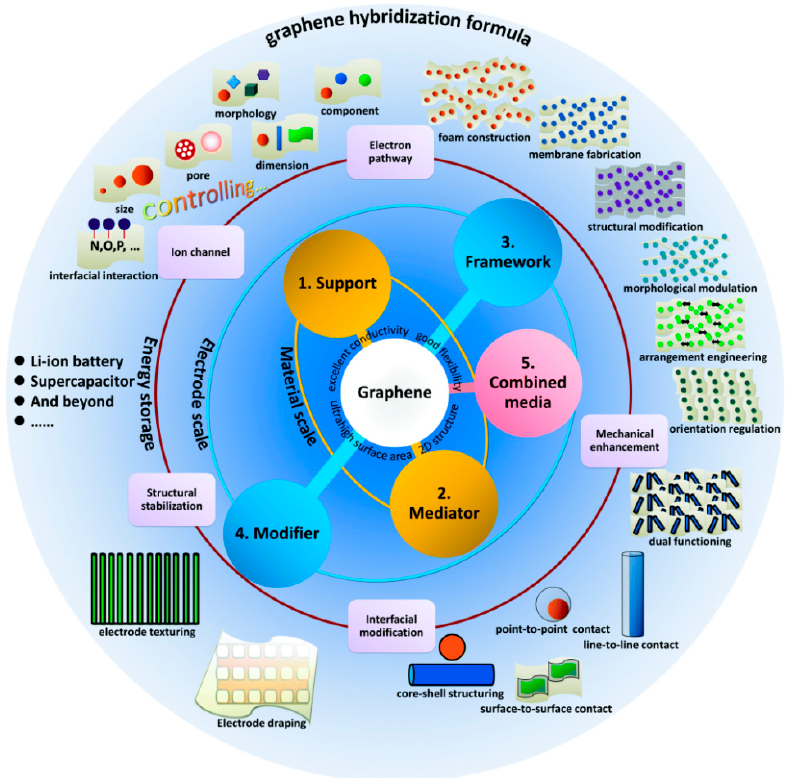
Figure 2. Overview of graphene hybridization formulas for energy storage applications. Reproduced from [7]. Copyright Royal Society of Chemistry, 2018.